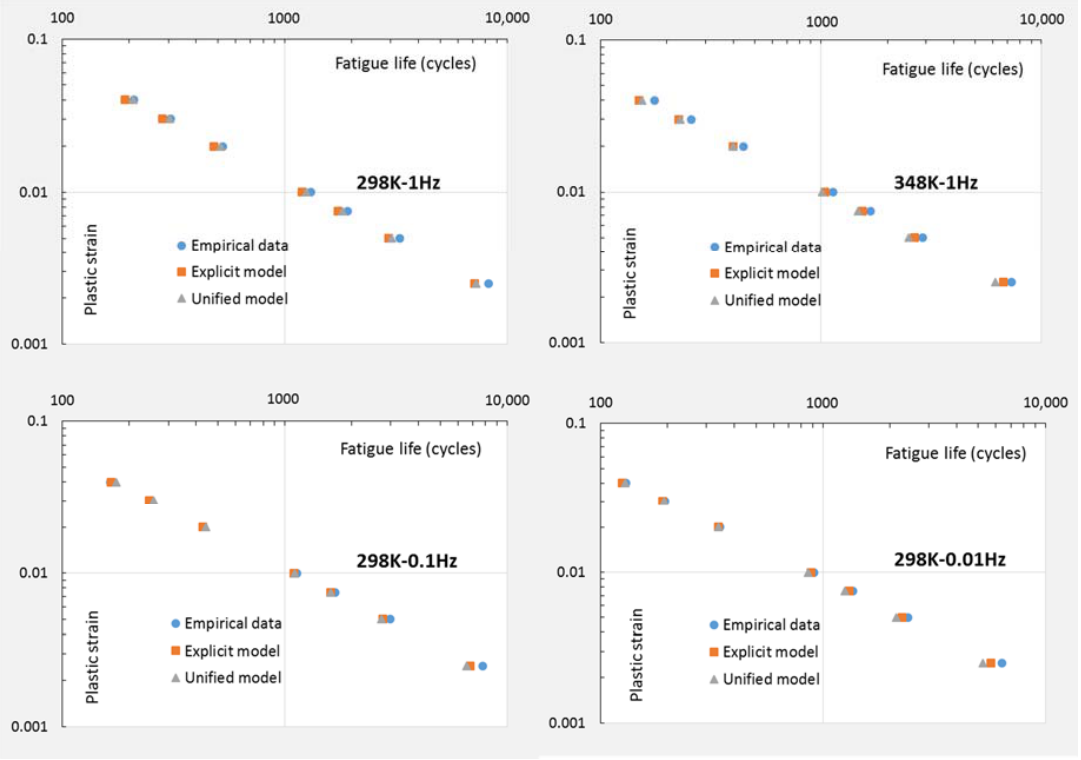
Figure 6. Empirical data and predicted life for 63Sn37Pb.